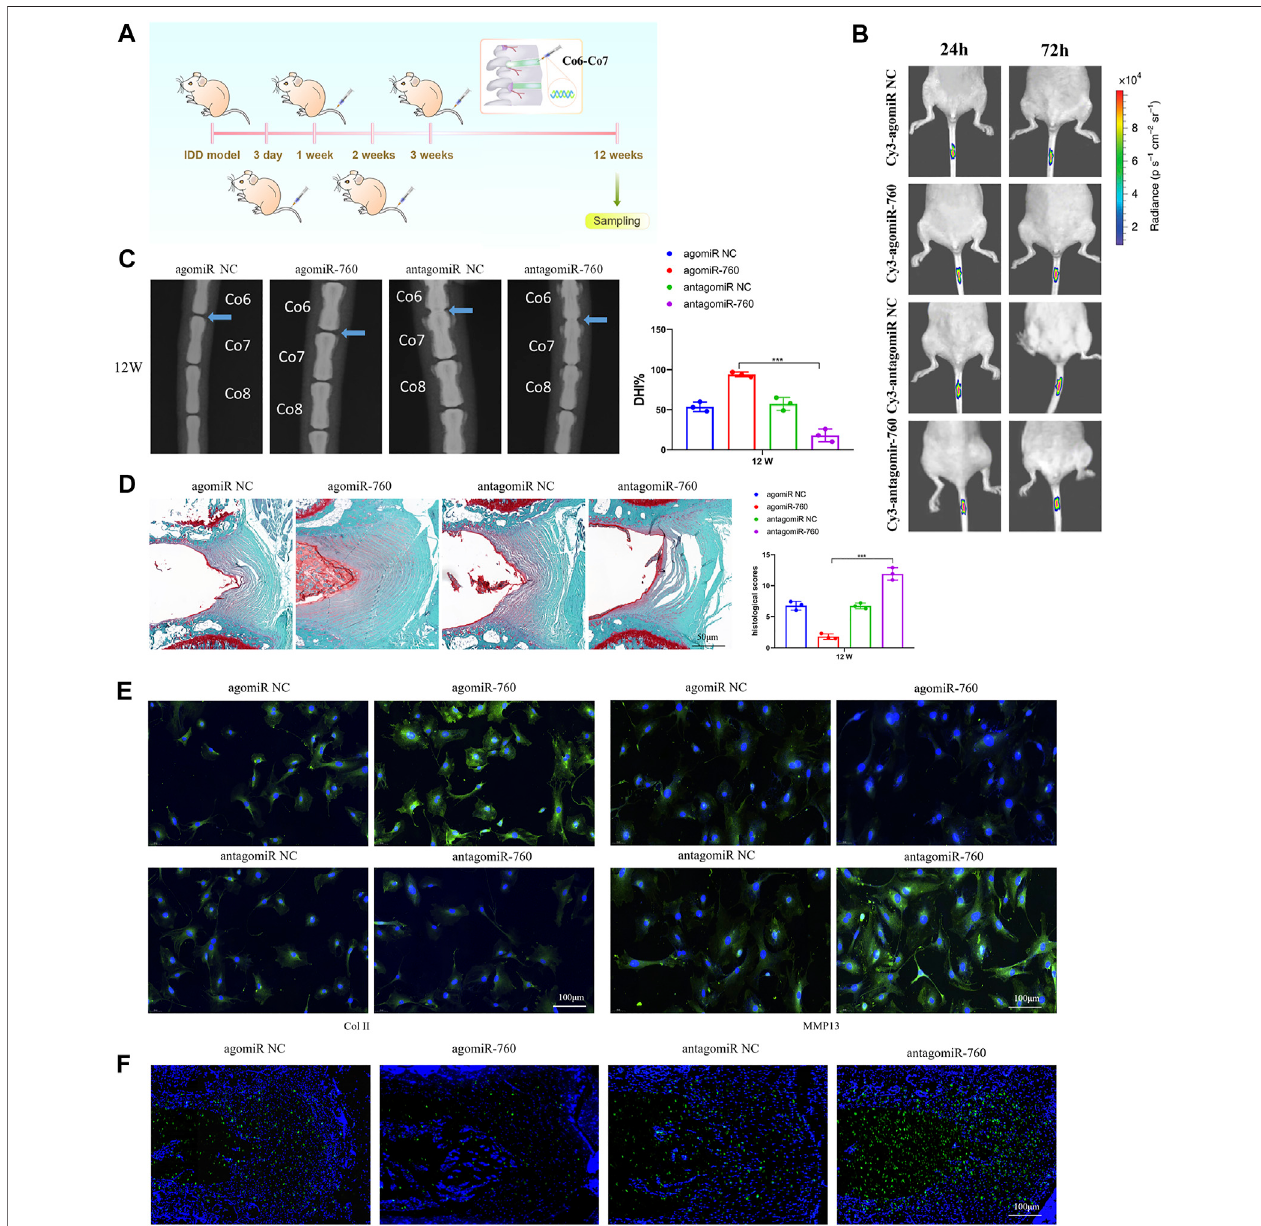
FIGURE 5 | Local injection of agomiR-760 attenuated IDD development. (A) Overview of the experimental set-up with deliveries of agomiR-760, agomiR NC, antagomiR-760 or antagomiR NC at 3, 7, 14, 21 days postoperatively. (B) Fluorescence image in mice at 24 and 72 h after the administration of Cy3-agomiR-760 showed that the delivery was ideal. The color bar (from blue to red) indicated the change in fl uorescence signal intensity from low to high. (C) Radiological outcomes of intervertebraldiscdegenerationwasevaluatedbyX-ray.Asigni fi cantincreaseinDHI%wasnotedinmice treatedbyagomiR-760 at12 weeksafter surgery. *** p < 0.001 by one-way ANOVA test followed by Tukey ’ s post hoc. (D) Histological outcomes of intervertebral disc degeneration was evaluated by Safranin O staining. The cells of the NP region in the intervertebral disc were more abundant in mice treated with agomiR-760. Mice treated by agomiR-760 showed a signi fi cant decreased histological score. *** p < 0.001 by one-way ANOVA test followed by Tukey ’ s post hoc. Scale bar = 50 μ m. (E) Immunostaining showed that agomiR-760 remarkably increased the expression of collagen II, while the expression of MMP 13 was decreased. Scale bar = 100 μ m. (F) TUNEL staining demonstrated that mice treated with agomiR-760 showed signi fi cantly decreased NP cell apoptosis. Scale bar = 100 μ